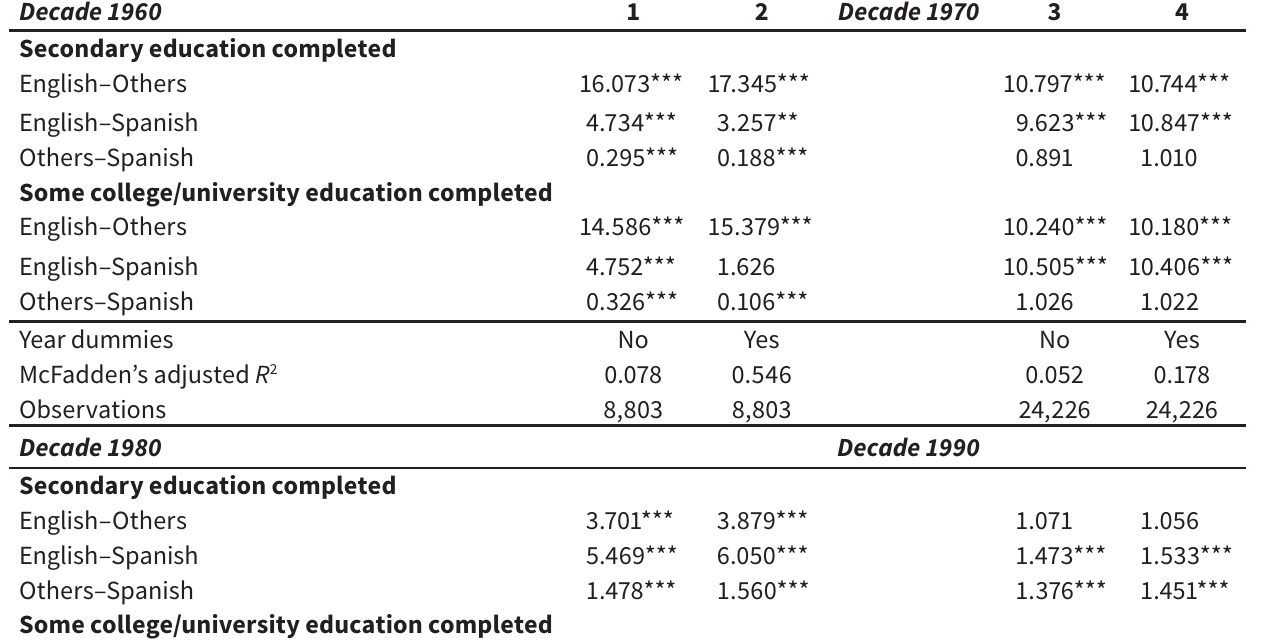
Analysis over time: decades 1960–2000 (dependent variable: languages – English, Spanish, and Others)